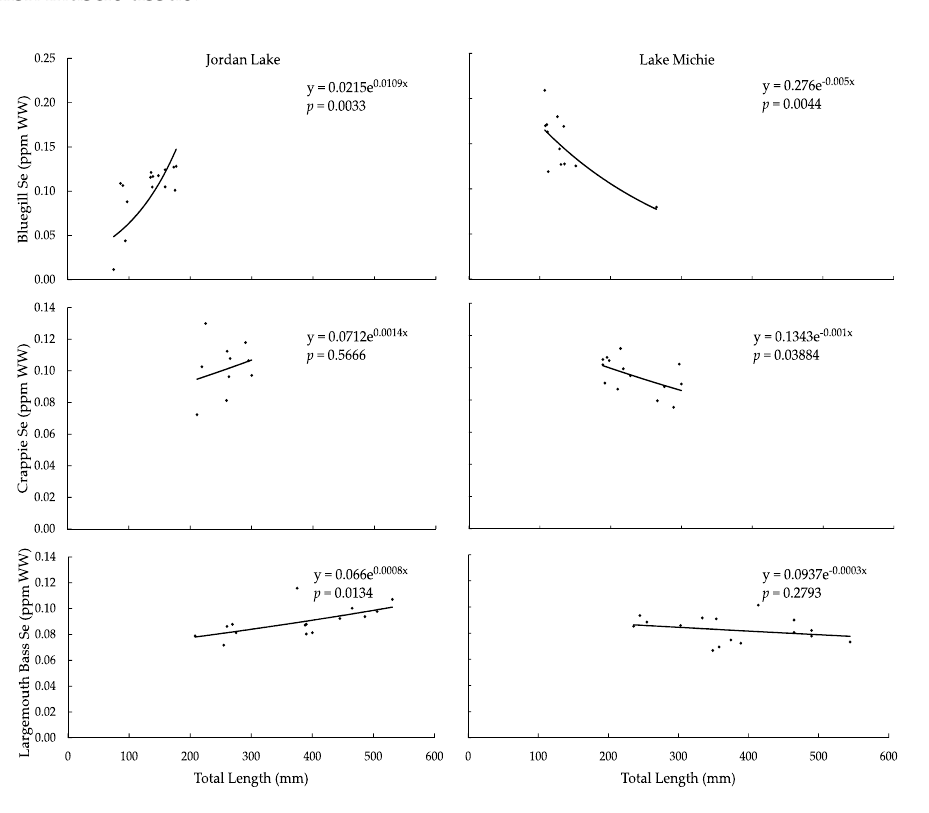
Figure 3. Tissue Se concentration (ppm WW) vs. total length (mm) in ( a ) bluegill from Jordan Lake, ( b ) bluegill from Lake Michie, ( c ) crappie from Jordan Lake, ( d ) crappie from Lake Michie, ( e ) largemouth bass from Jordan Lake, and ( f ) largemouth bass from Lake Michie.